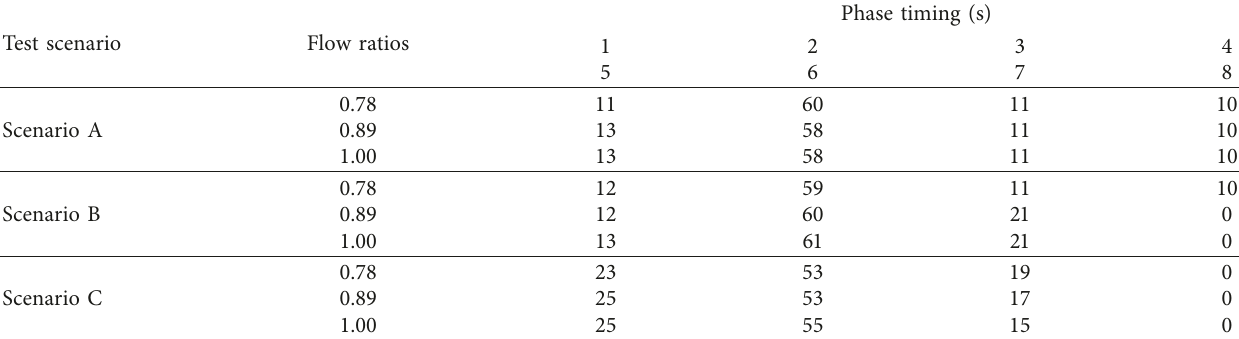
Table 3: Results of phase timing